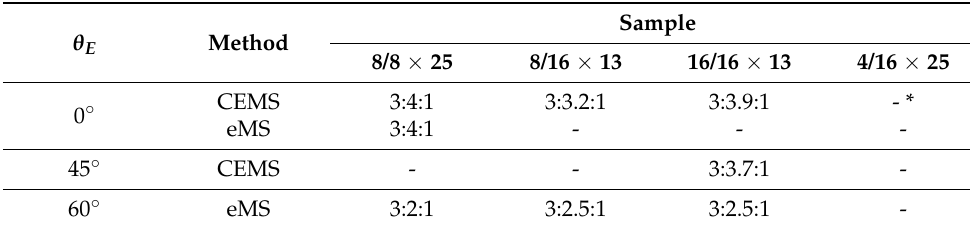
Table 2. The line intensity ratio of the sextet component measured at different emission angles ( θ E ), i.e., the angle between the principal axis of the electric field gradient tensor (sample surface normal) and the gamma emission